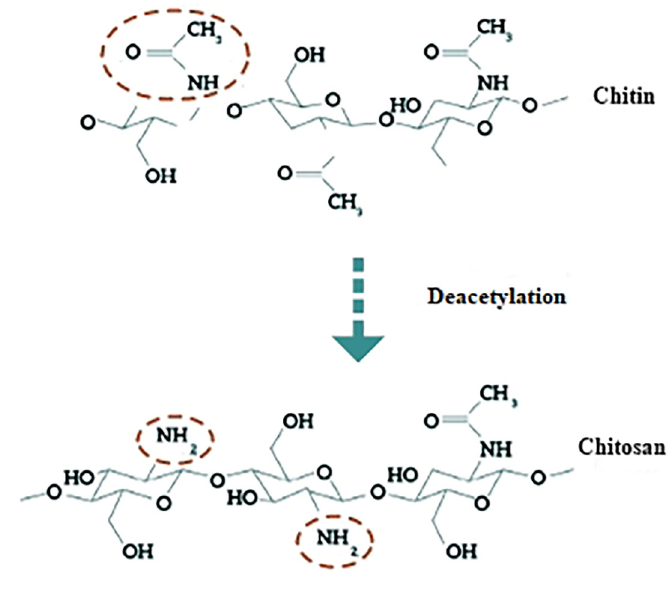
Figure 3. Deacetylation of chitin to